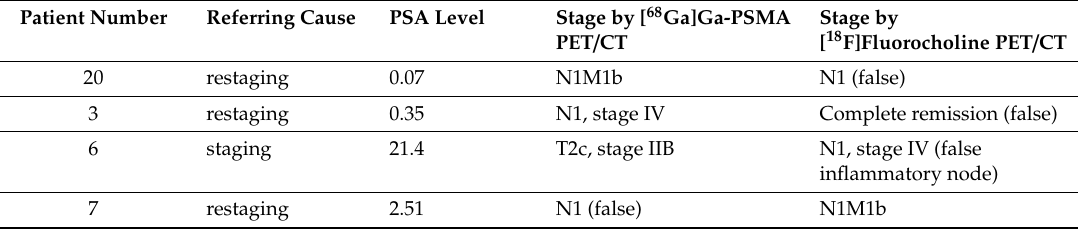
Table 3. Patients with di ff erent TNM staging by two imaging modalities.